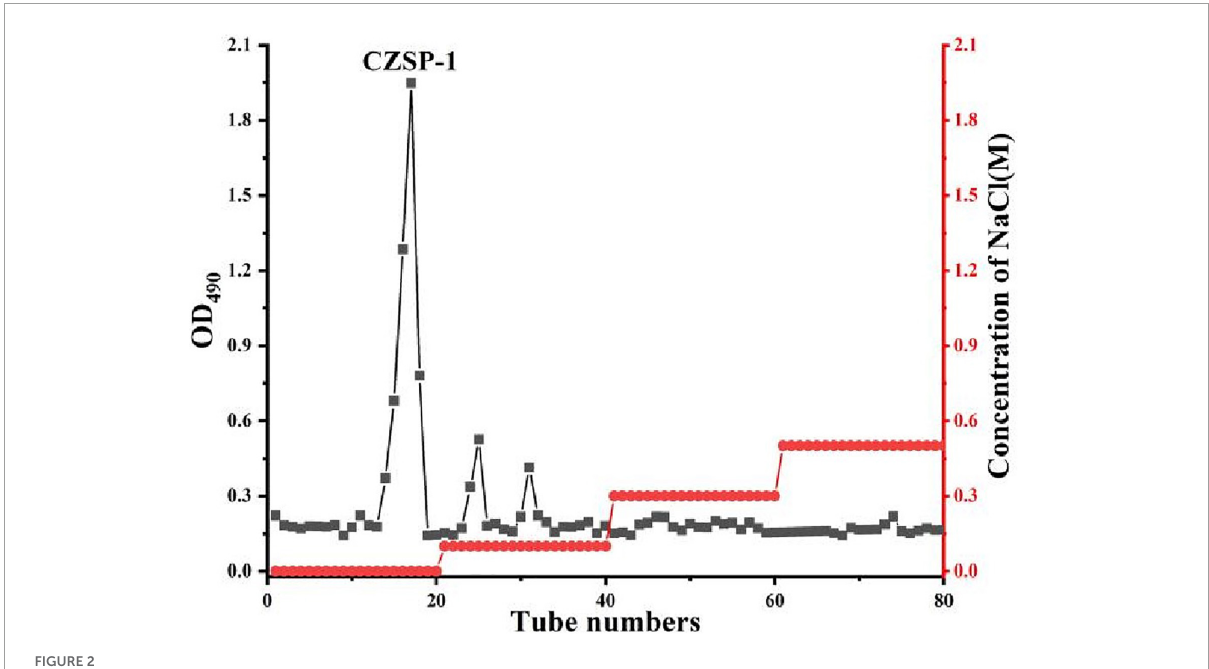
FIGURE2 Elution profile of CZSP-1 on DEAE-cellulose-52